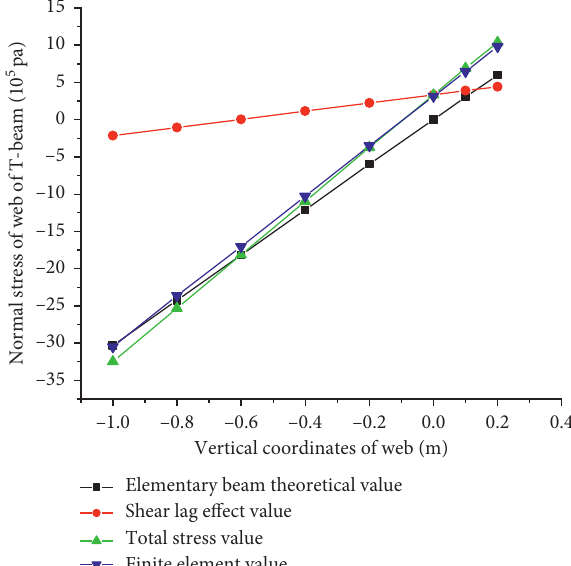
Figure 6: Stress on T-beam webs near the bridge bearing for continuous T-beams ( L